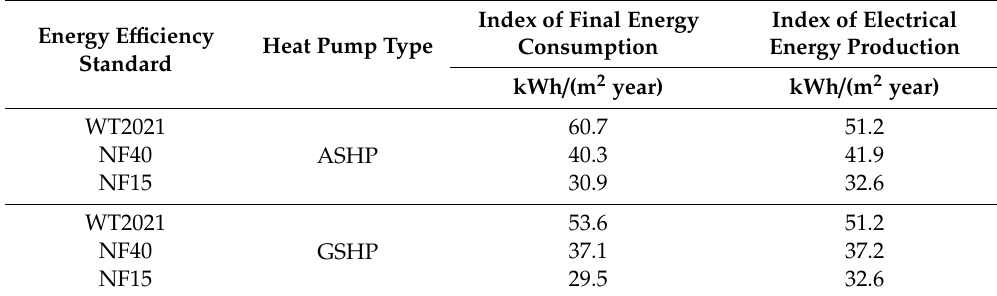
Table 13. Final energy indexes for the WT2021, NF40 and NF15 standards.